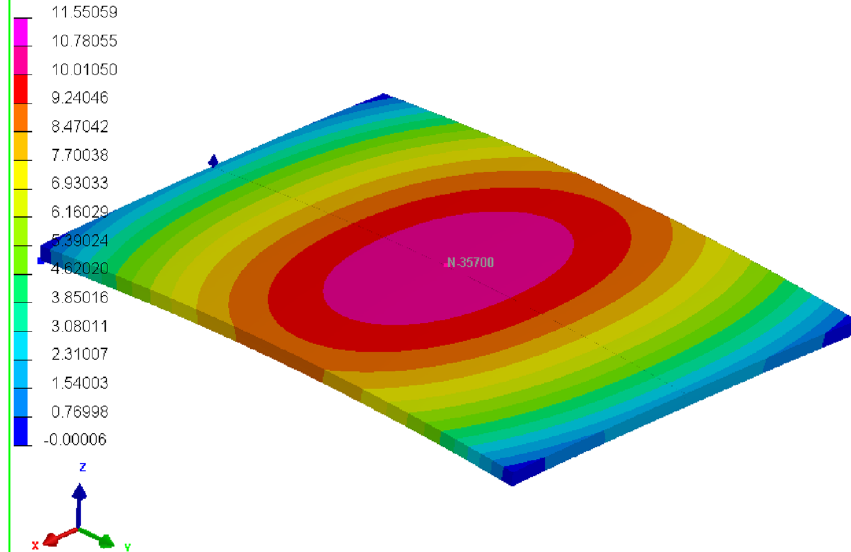
Figure 4. Curved forming shape.